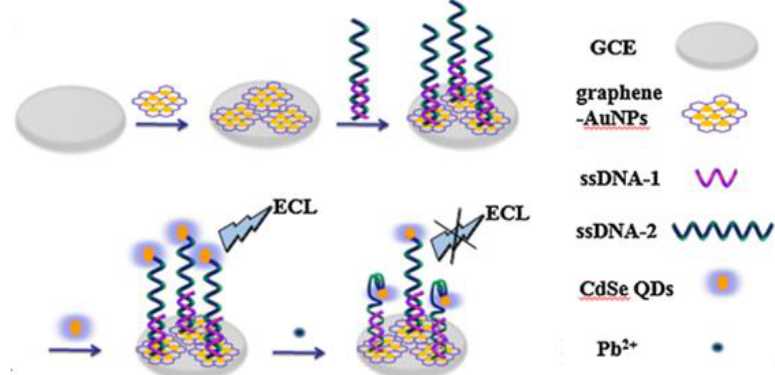
Figure 5. Metal ion-induced quadruplex construct for ECL-based HM detection The Pb 2+ causes the